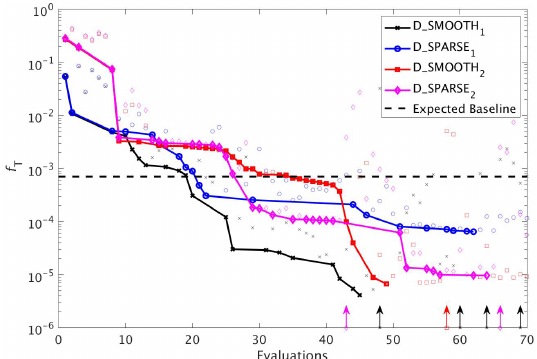
Figure 12. As in Fig. 8, but for experiments D_SMOOTH 1 (black line with crosses), D_SPARSE 1 (blue line with circles), D_SMOOTH 2 (red line with squares) and D_SPARSE 2 (magenta line with diamonds). Vertical arrows indicate a soft restart, coloured and marked according to each experiment. Note that the baseline misfit (horizontal black dashed line) was calculated using the full grid noisy